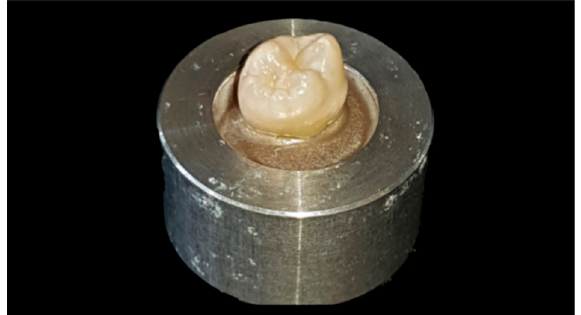
Figure 1. Tooth embedded into aluminum body, before preparation.